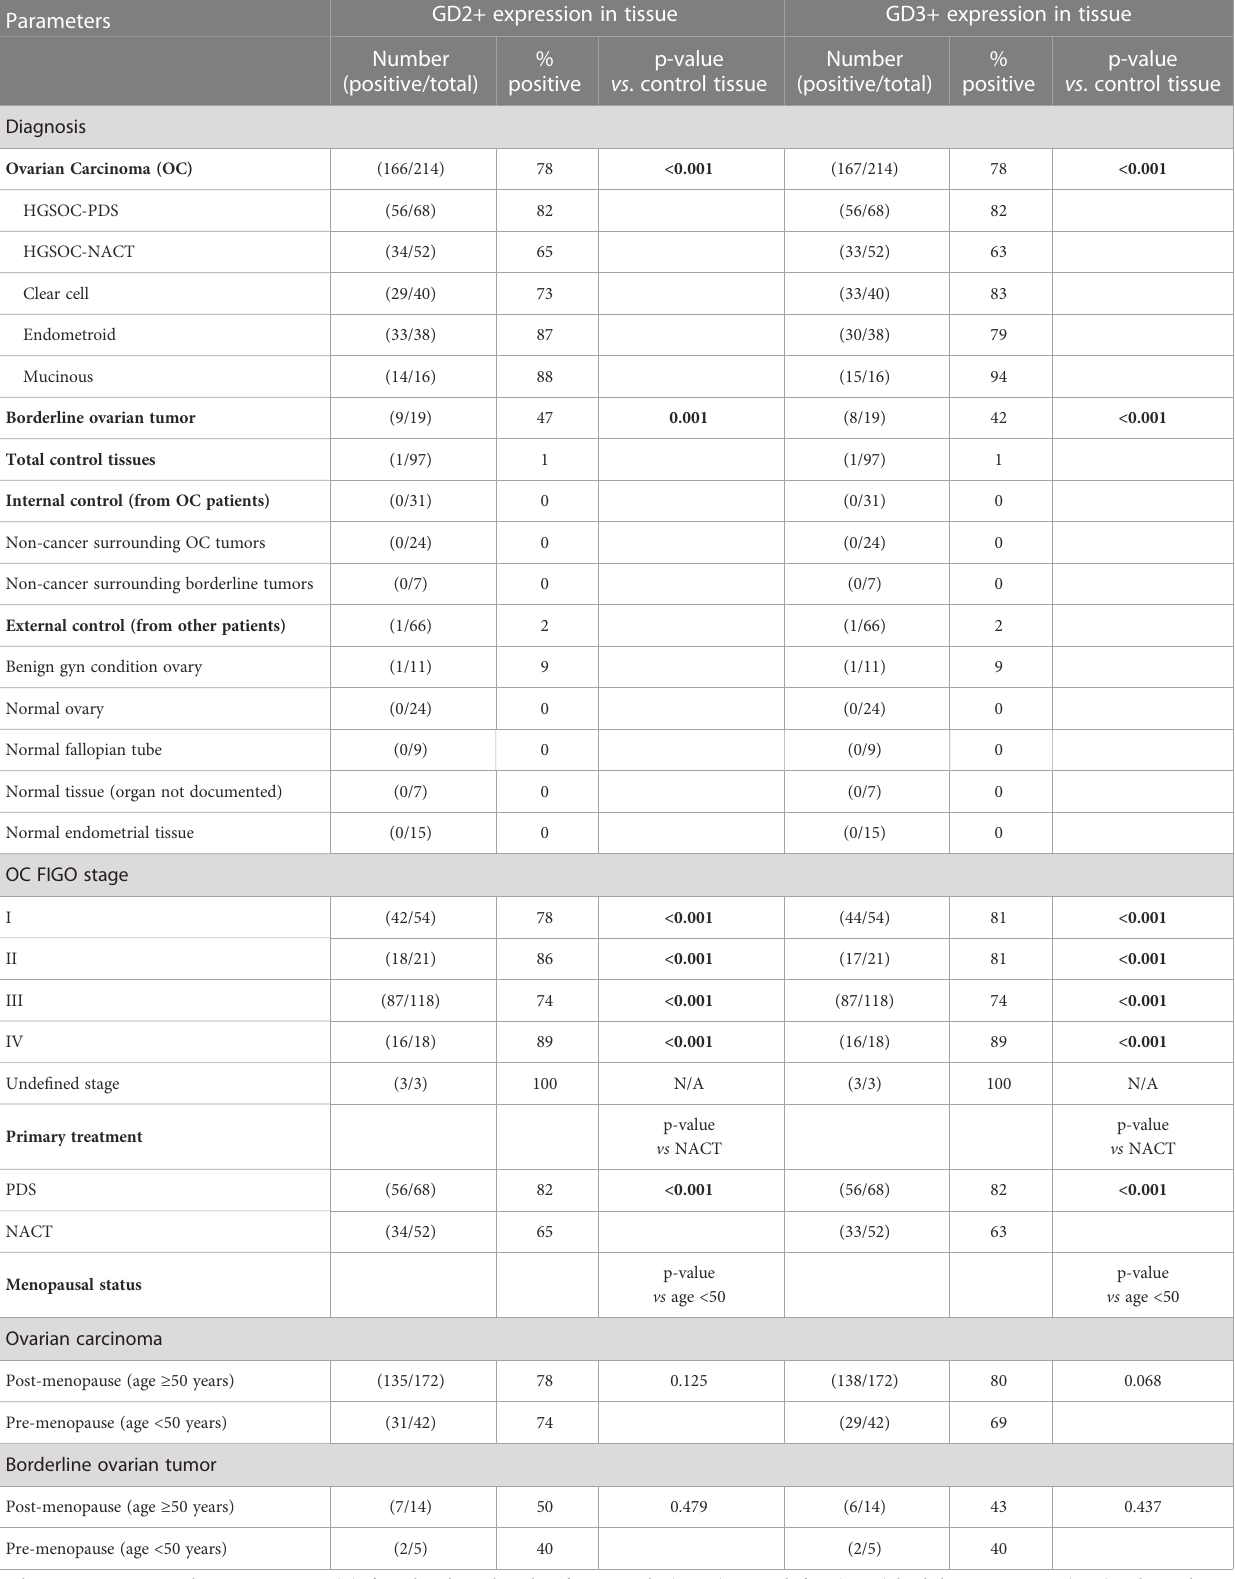
TABLE 1 Summary of immunohistochemistry analysis of GD2 and GD3 expression in combined analysis of tissue biopsy block sections and